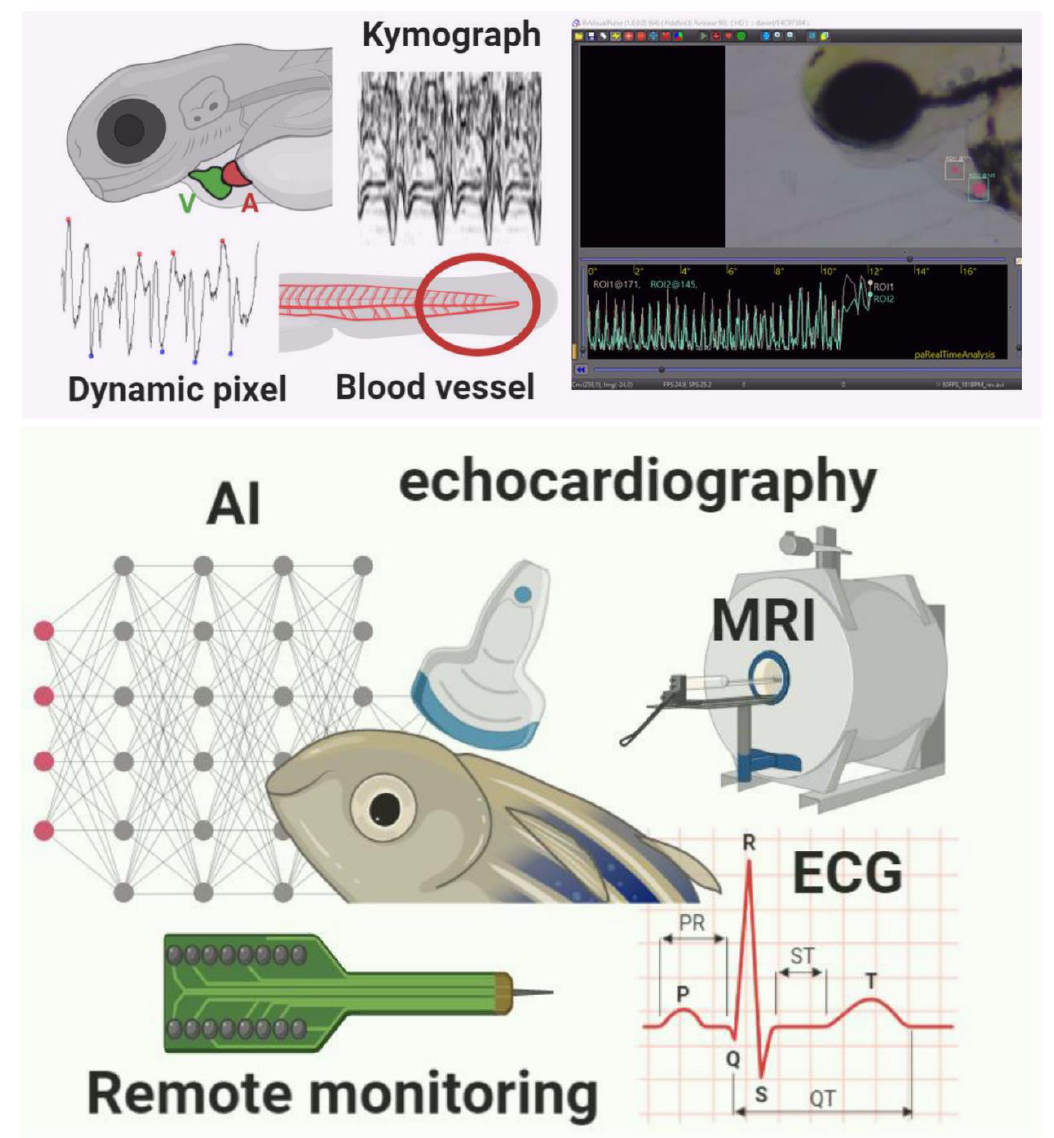
Figure 1. Summary of different methods used to measure cardiac rhythm in either embryo (upper red panel) or adult (bottom green panel) zebrafish. Several methods based on either dynamic pixel change or kymograph are proposed in the embryonic stage of zebrafish. Some commercial third-party software is also available for cardiac rhythm measurement. In adult zebrafish, some instruments like Electrocardiography (ECG), Echocardiography (Echo), and Magnetic Resonance Imaging (MRI) can be used for cardiac rhythm measurement.